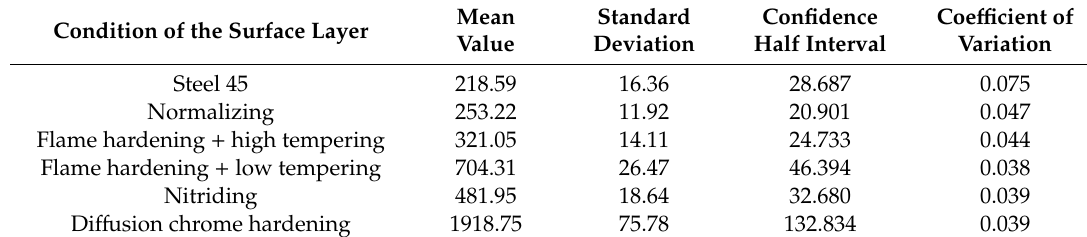
Table 7. HV01 hardness of the surface layer.